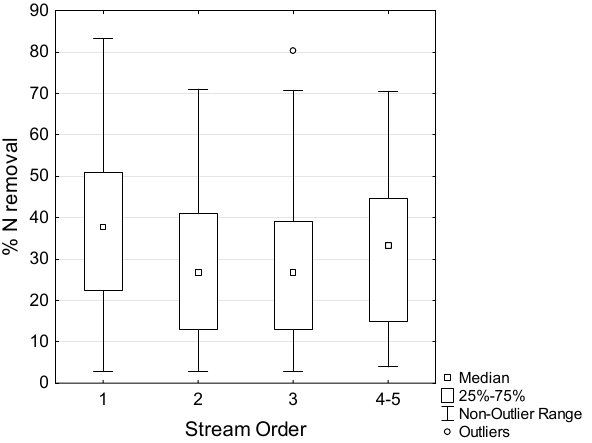
Figure 3. Nitrogen removal (%) of the 2206 N removal dams draining to the Atlantic from New England distributed by stream order. Outliers are values >1.5 times the interquartile range.